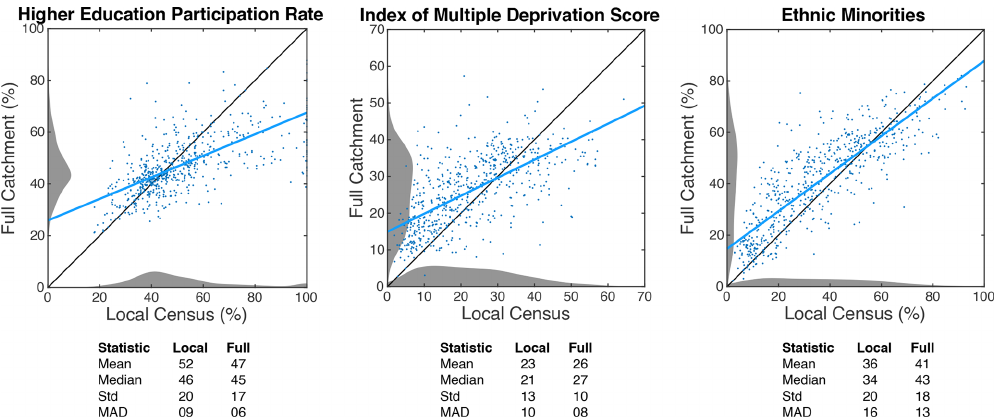
Figure C1. Comparison of local census and full catchment data for all schools across greater London ( n = 625), with a linear regression (blue line) and marginal distributions (grey areas) shown. Location (mean and median) and scale (standard deviation and median absolute deviation) parameters for the two types of data are also